Question: Sum up the contents of this chart in one sentence.
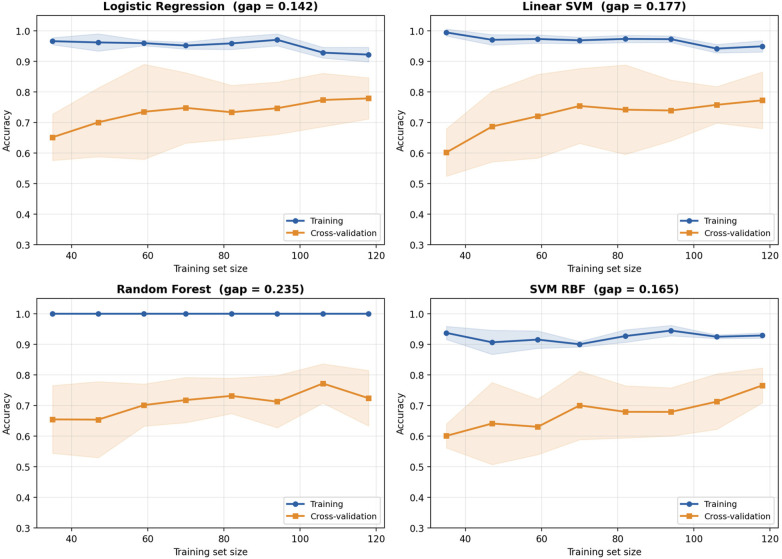
Answer: Learning curves for the four classification algorithms. Training and cross-validation accuracy are shown as a function of training set size. The final train–validation gap was smallest for Logistic Regression (0.142) and largest for Random Forest (0.235), suggesting a greater overfitting tendency for the tree-based model.